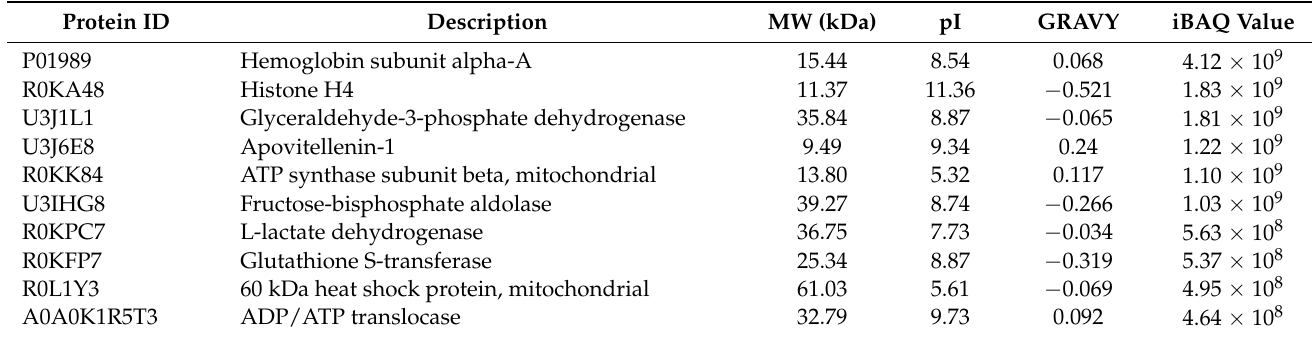
Table 4. Rank of the top 10 proteins of the highest signal strength in the PPSGP